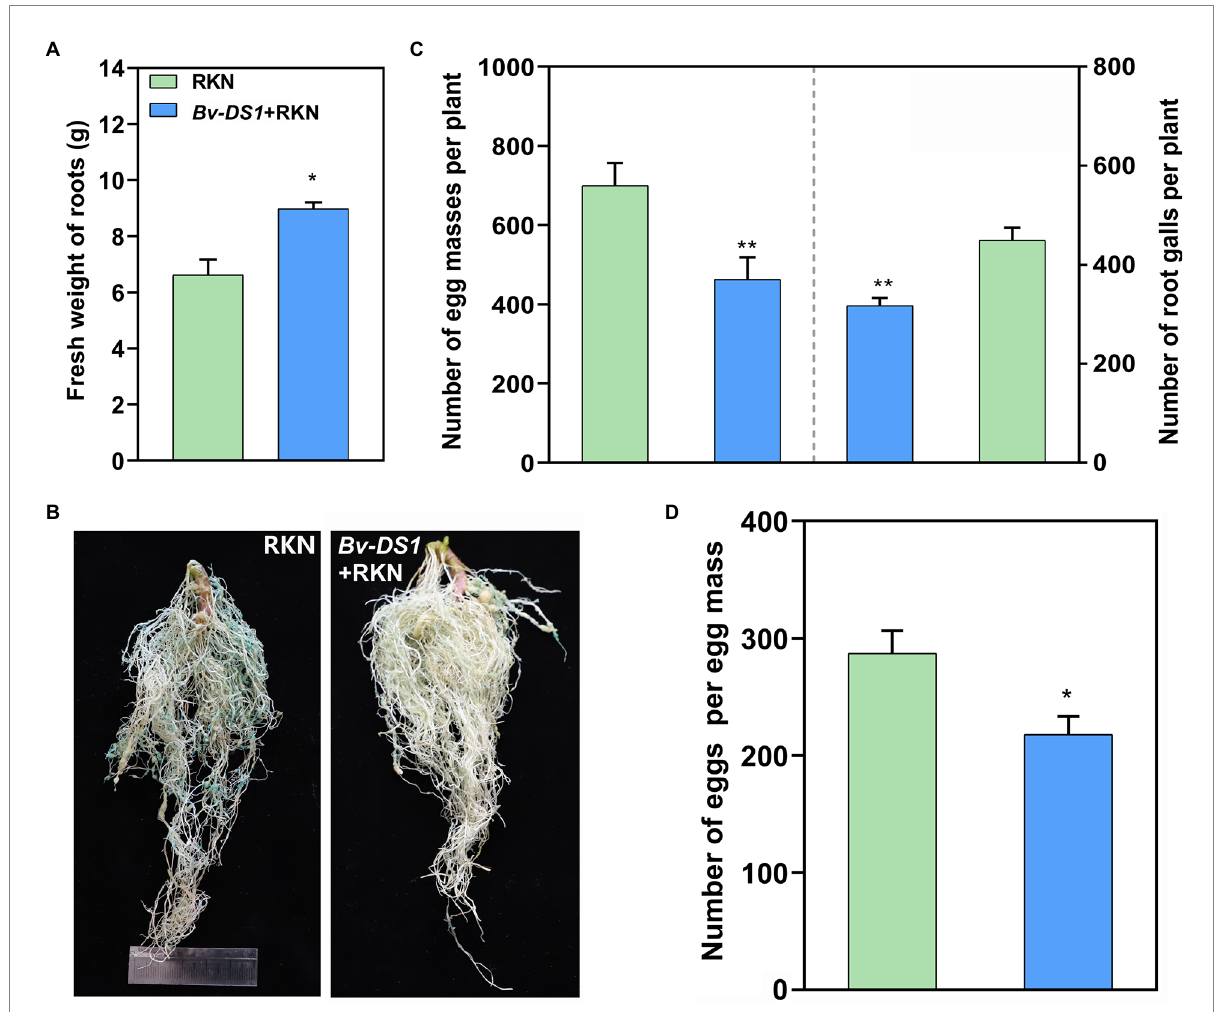
FIGURE 4 Bacillus velezensis YS-AT-DS1 ( Bv-DS1 ) reduced M. incognita infection when tomato plants were grown in diseased soil. (A) Fresh weight of tomato roots pre-inoculated or non-inoculated with Bv-DS1 growing in the RKN-diseased soil for 42 days. (B) Root galling and egg masses on tomato plant pre-inoculated or non-inoculated with Bv-DS1 . (C) Number of galls or egg masses per tomato plant. Data are presented as mean ± SE of 10 plants for each treatment. Asterisk indicates significant differences between treatments ( p < 0.05) according to Student’s t test. (D) Number of eggs per egg mass. Data are shown as mean ± SE of eight plants for each treatment. Asterisk indicates significant differences between treatments ( p < 0.05) according to Student’s t